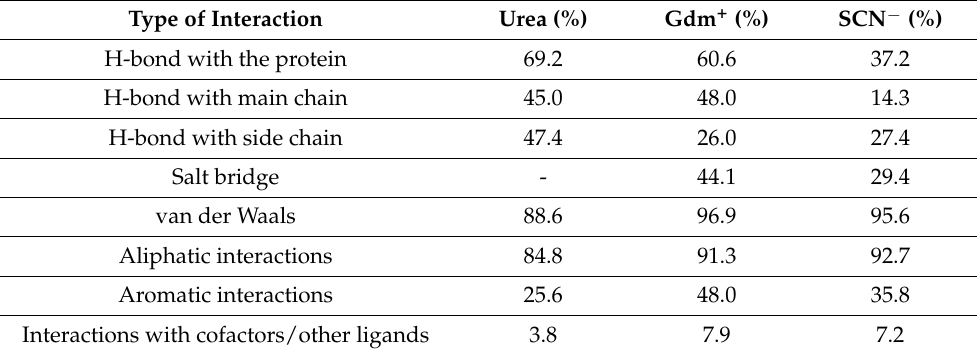
Table 1. The frequency of interactions established by ligands in our dataset of protein structures is reported as the percentage of total ligand binding sites (289 for urea, 127 for Gdm + , 712 for SCN − ). Gdm + and SCN − related data were retrieved from refs